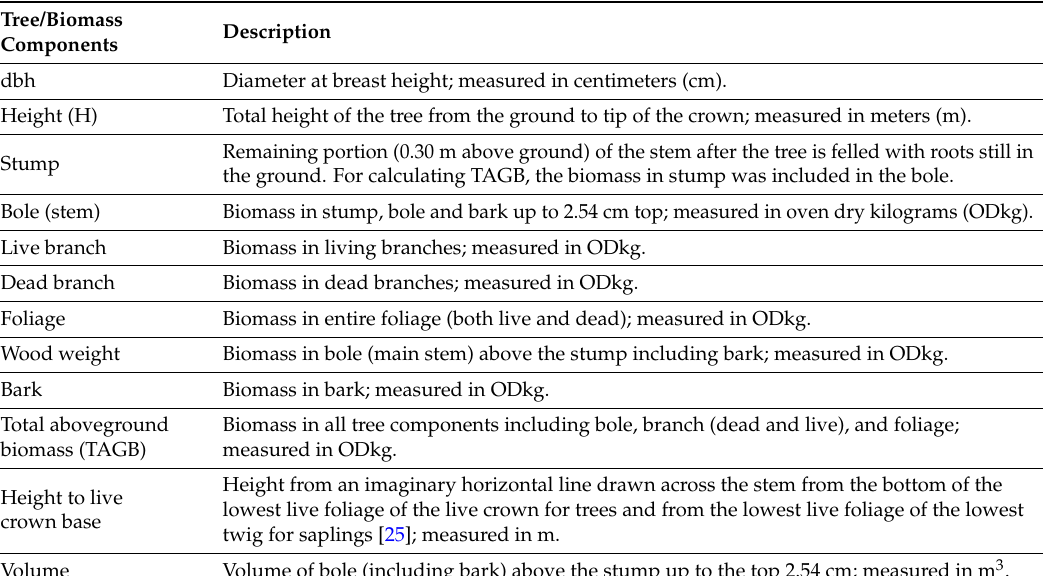
Table 1. Description of tree components and dimensions used for the study to develop localized allometric models for coast